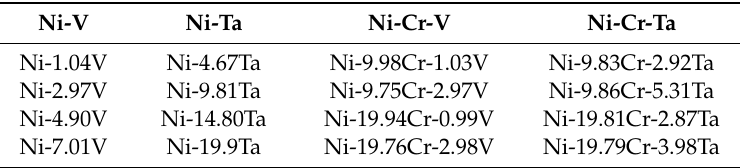
Table 2. The compositions of the investigated alloy